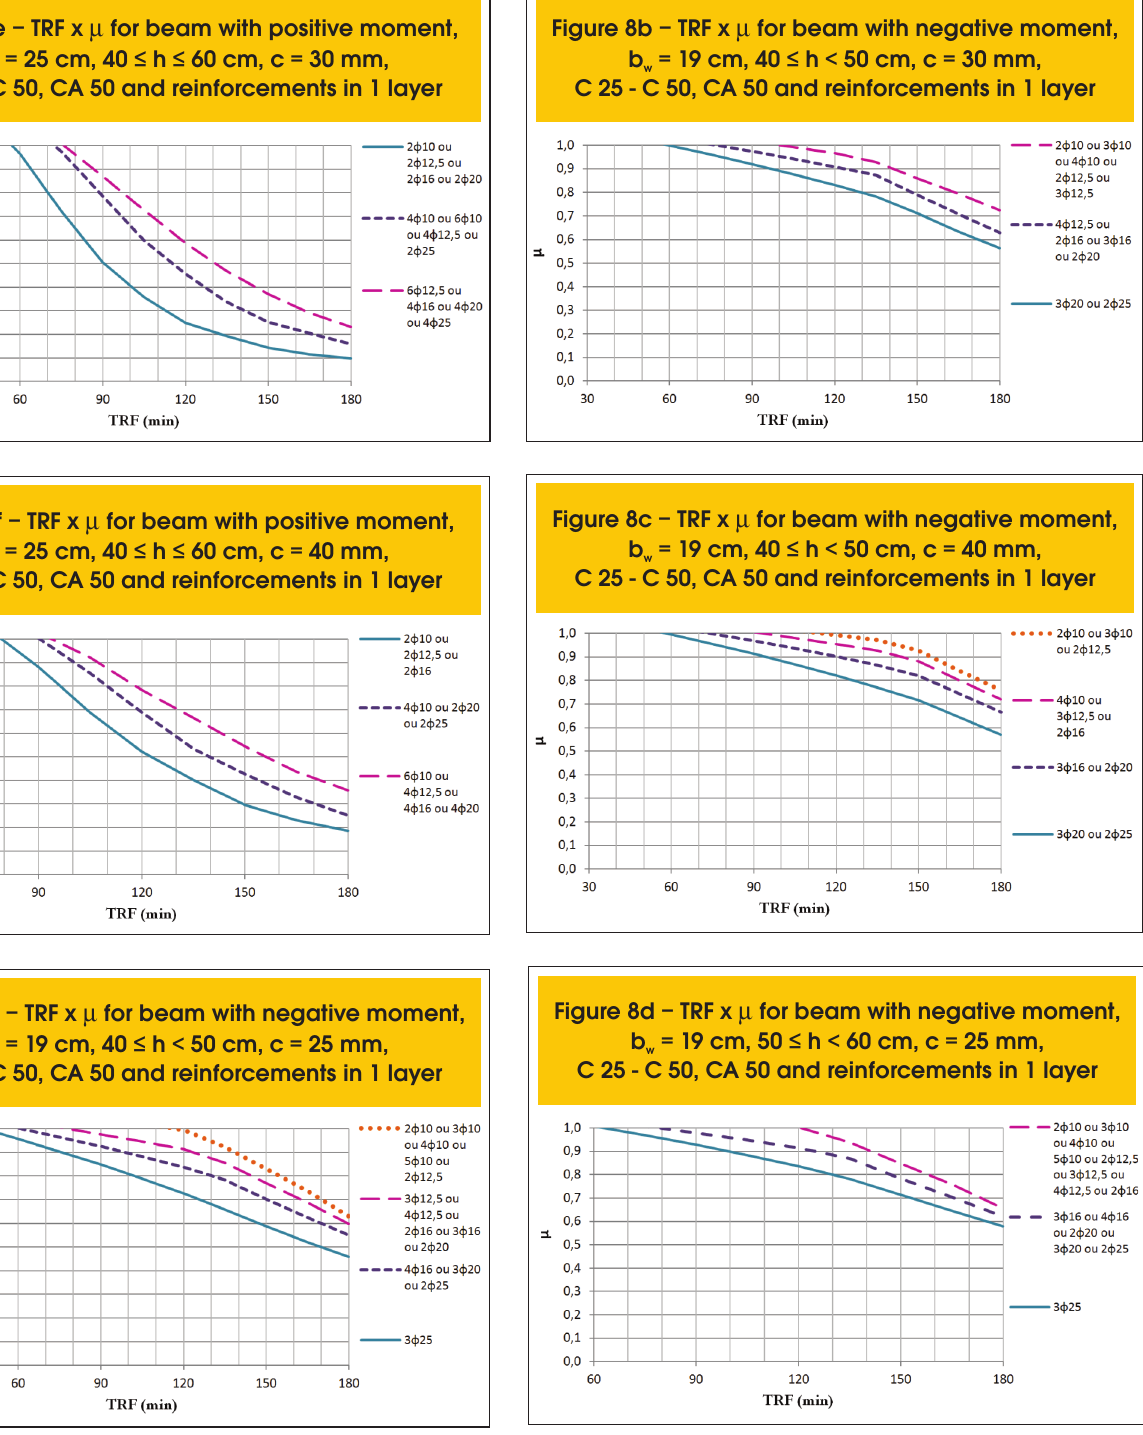
Figure 8b – TRF x m for beam with negative moment, b = 19 cm, 40 ≤ h < 50 cm, c = 30 mm, w C 25 - C 50, CA 50 and reinforcements in 1 layer